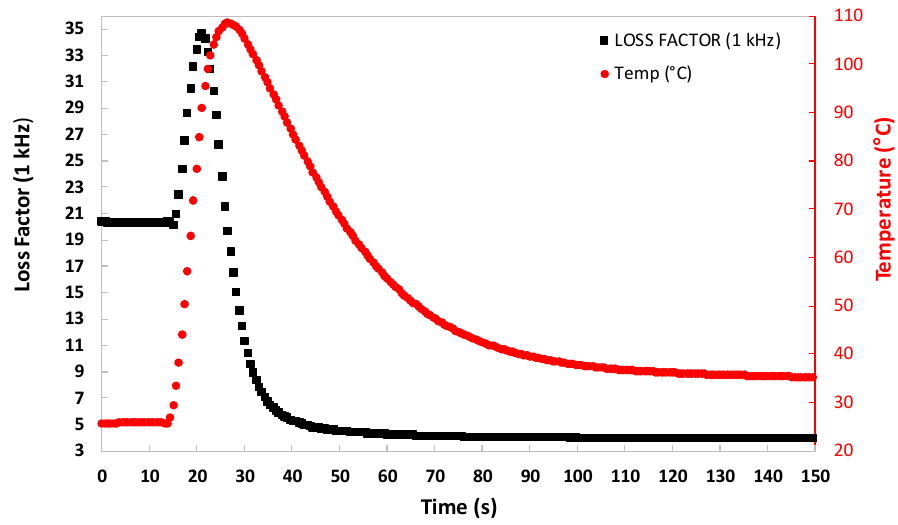
Figure 6. Loss factor ( ■ ) and temperature ( ● ) in the curing process, analysed by dielectric analysis (DEA) of the UV prepreg composed of 15 wt.% MAT225.